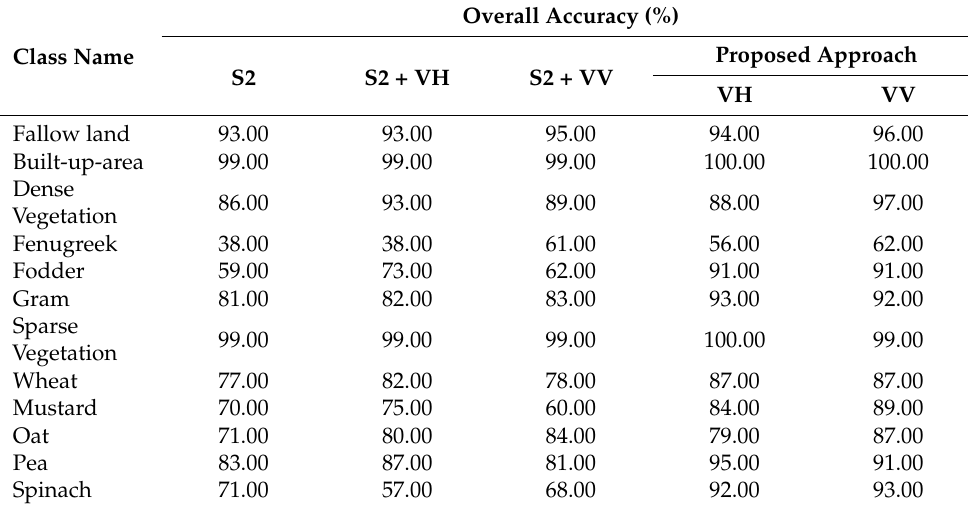
Table 5. Class-wise accuracy for Sentinel 2B (S2), S2 layerstacked with VH-VV polarization separately (i.e., S2 + VH and S2 + VV), and fused image by proposed fusion approach using XGB